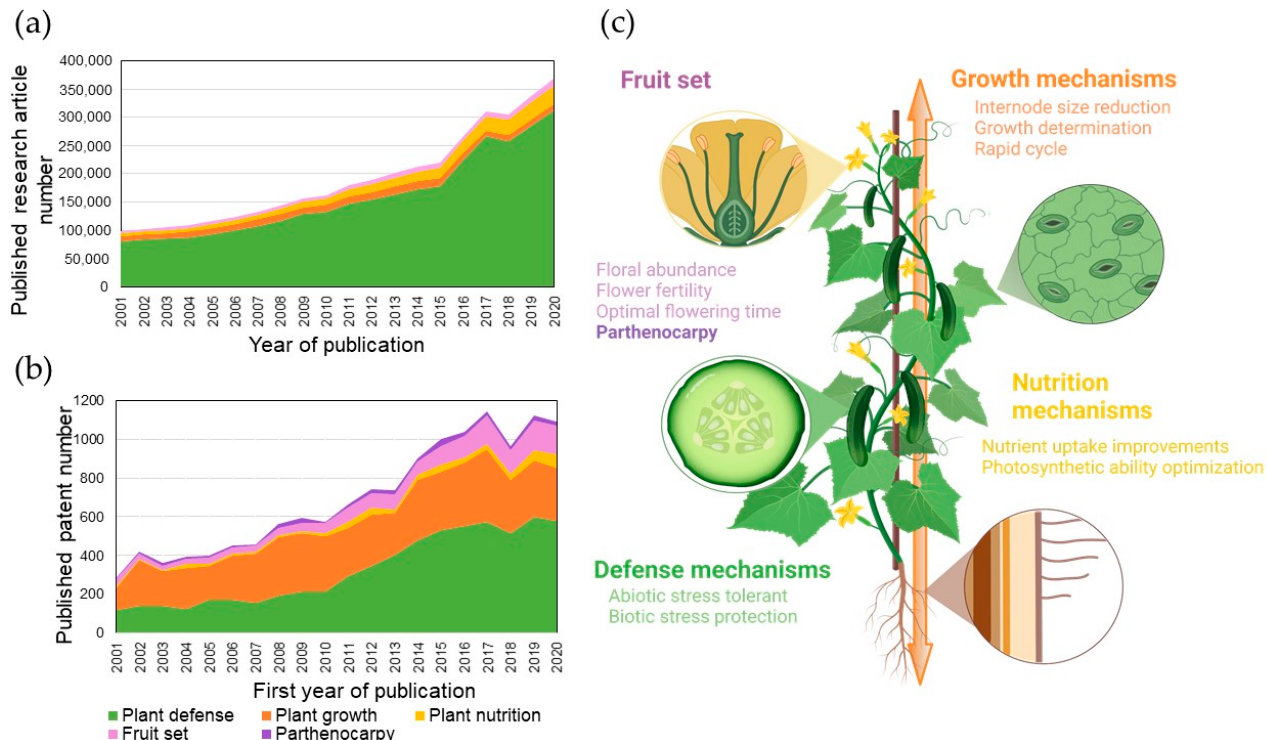
Figure 4. Genetic improvements to crops needed for sustainable agriculture. ( a ) The number of published patents and ( b ) research articles related to genetic improvement of fruits and vegetables and ( c ) traits to target in plant breeding. Created with BioRender.com. The data come from the Orbit Intelligence patent database (https://intelligence.orbit.com, accessed on 29 April 2021) and Web of Science (https://www.webofscience.com, accessed on 29 April 2021).